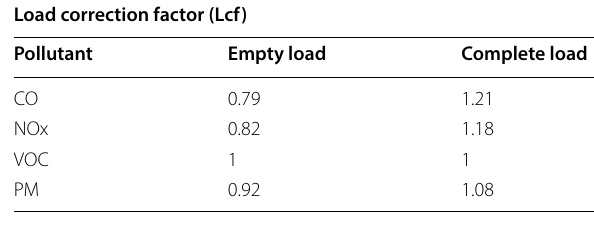
Table 3 Load correction factors applied to heavy duty